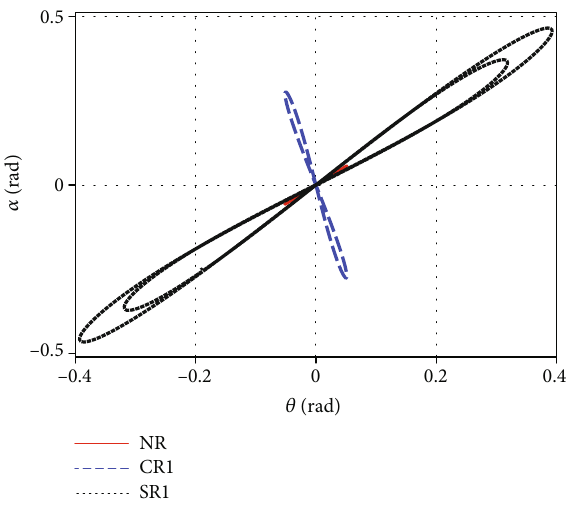
Figure 14: The phase diagram of basic periodic solutions in e = 0 : 05 under NR, CR1, and SR2.